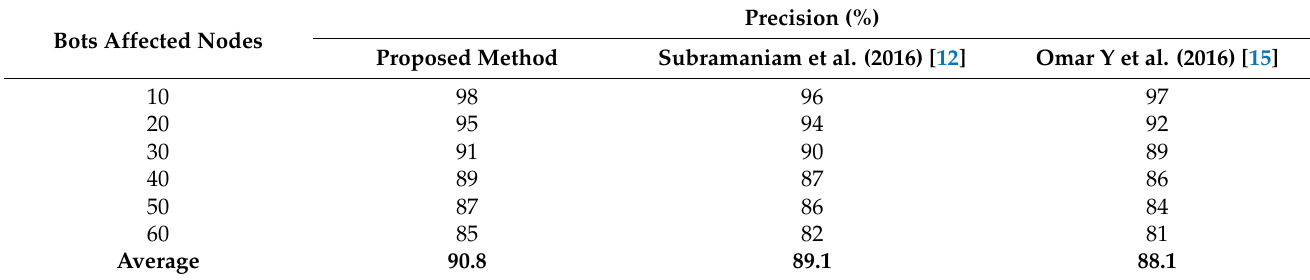
Table 7. Comparisons of